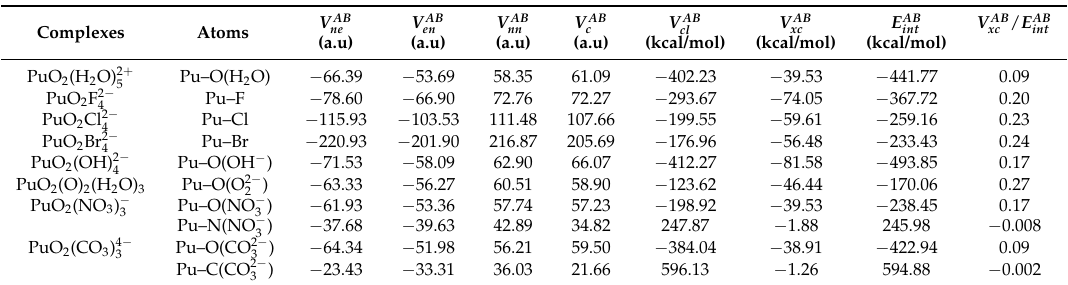
Table 5. Decomposition of Pu–L interaction energies within the IQA framework for all relevant interactions in studied Plutonyl (VI)